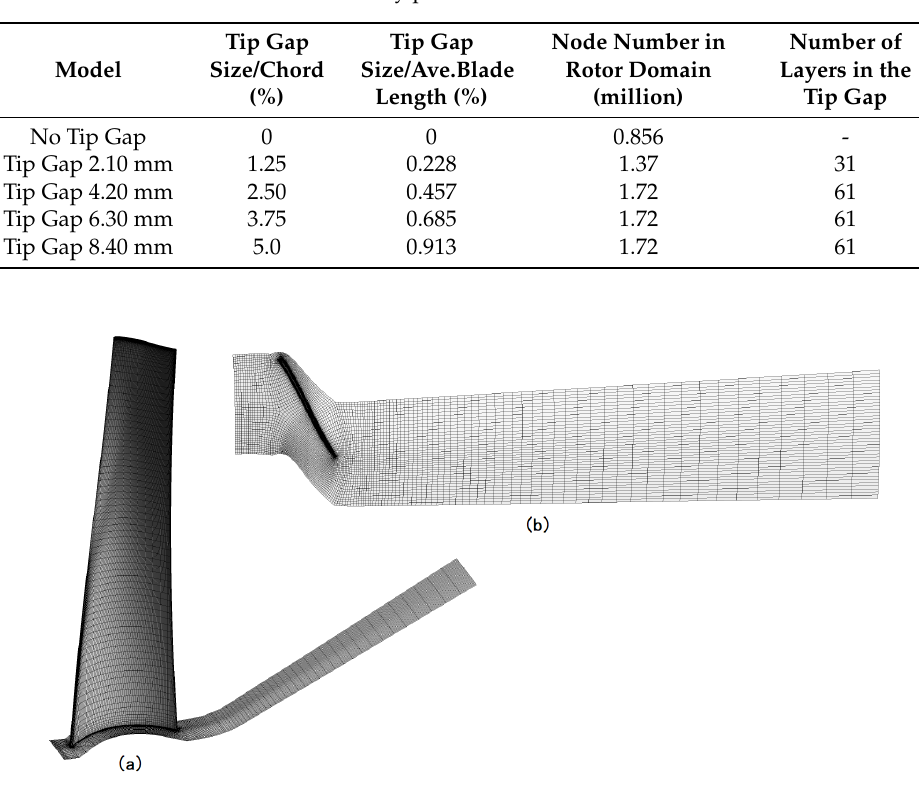
Table 2. Geometry parameter of the five models.